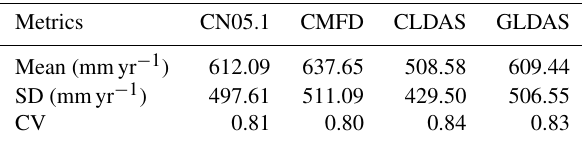
Table 3. Statistical metrics summarizing the spatial average and variability of annual mean precipitation during